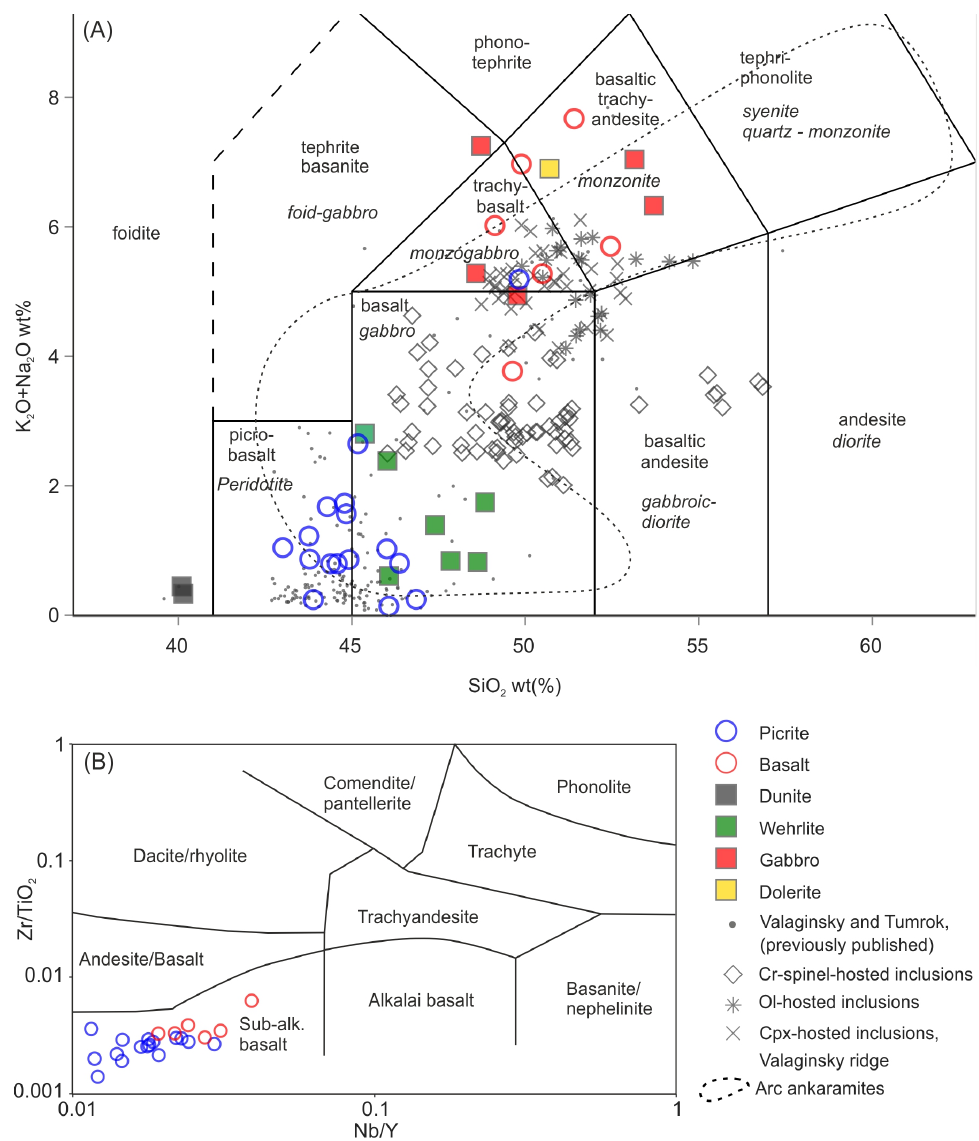
Figure 14. Compositions the studied rocks and inclusions on the classification plots. ( A ) TAS diagram [96] for the volcanic rocks and their plutonic counterparts [97]; ( B ) Nb/Y-Zr/TiO 2 diagram for volcanic rocks [92]. Data for melt inclusions are from this study and [54,57,61]. Data sources for the fields of arc ankaramites are in Figure 10.